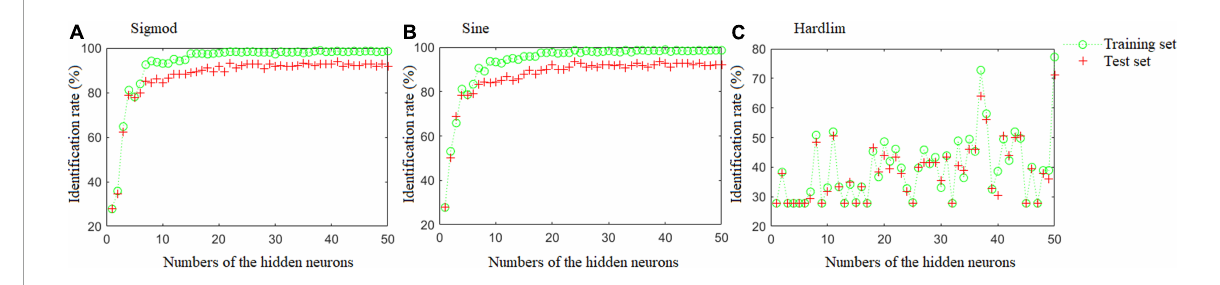
FIGURE4 The results of the ELM models with different activation functions and numbers of hidden neurons.